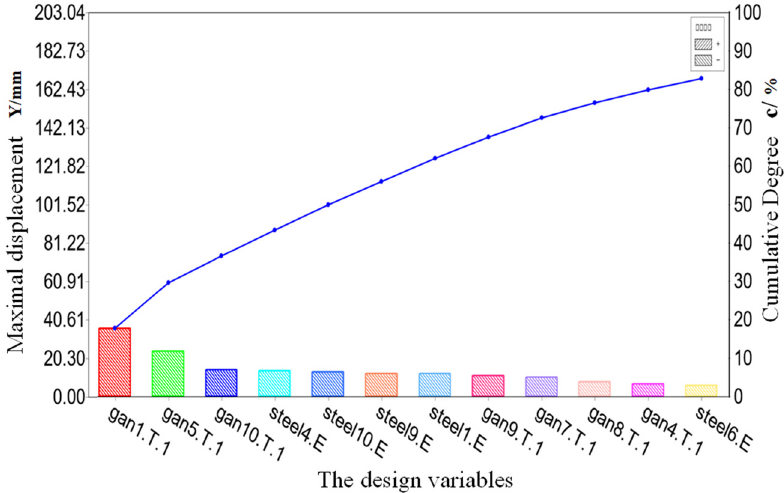
Figure 15: The result of the sensitivity analysis with displacement parameters under wind and snow conditions.